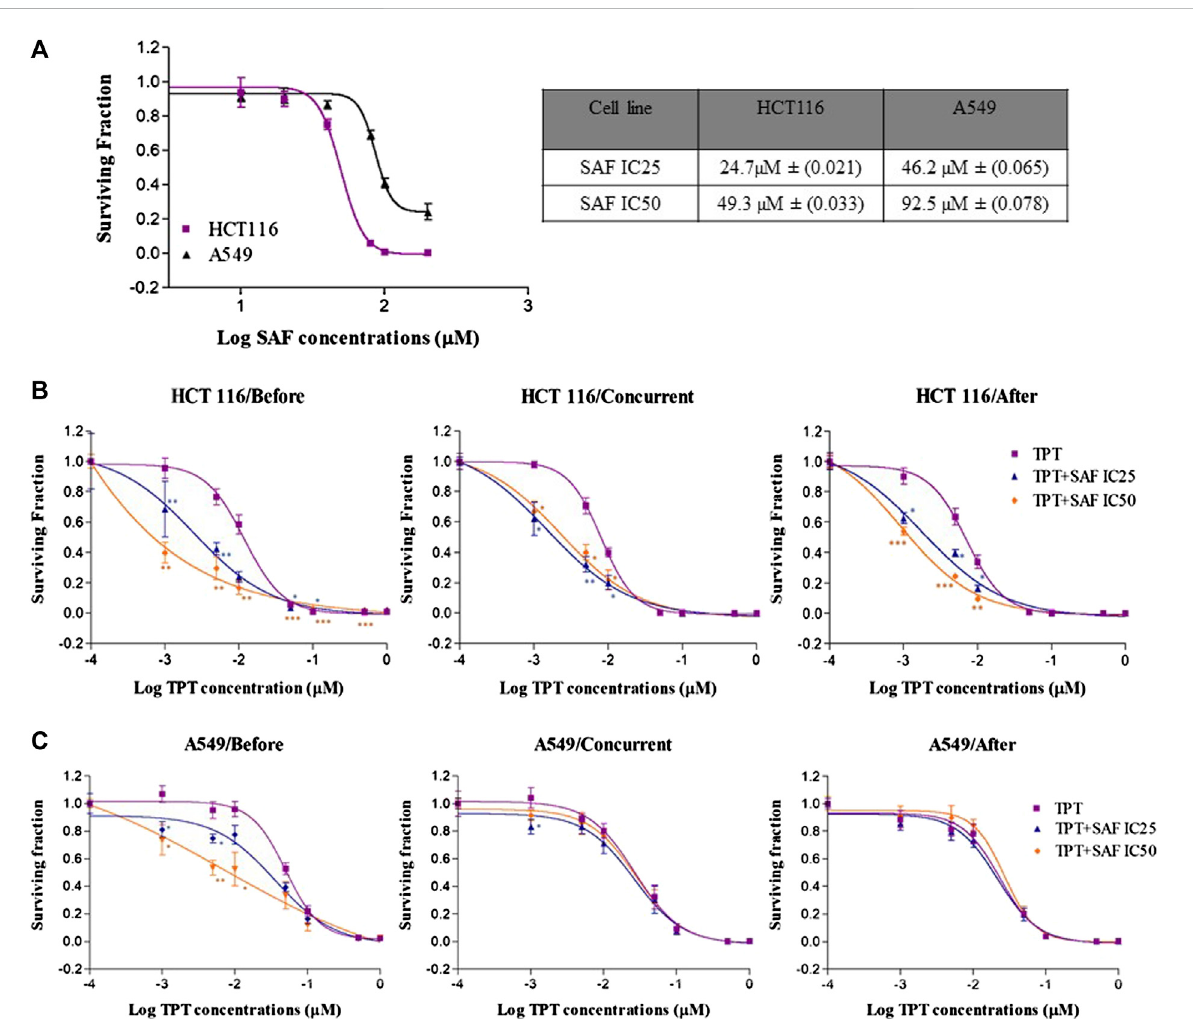
FIGURE 1 Effect of SAF IC25/IC50 on the sensitivity of both HCT116 and A549 cells to topotecan treatment by using different sequences. (A) Colony formationassaywasusedtomeasurethesensitivityofHCT116andA549cancercelllinestodifferentconcentrationsofSAF(µM). (B – C) HCT116and A549 cells were treated with IC25/IC50 concentrationsof SAFeither 24 hbefore, concurrentlyor 24 hafter treatmentwith differentconcentrations ofTPT(µM).Survivingfractioniscalculatedbydividingtheplatingef fi ciency(PE)oftreatedcellsbythe(PE)ofcontrolcells.Themeans±SEMof at least two independent experiments are shown. * p < 0.05, ** p < 0.005, and *** p < 0.0005 vs TPT